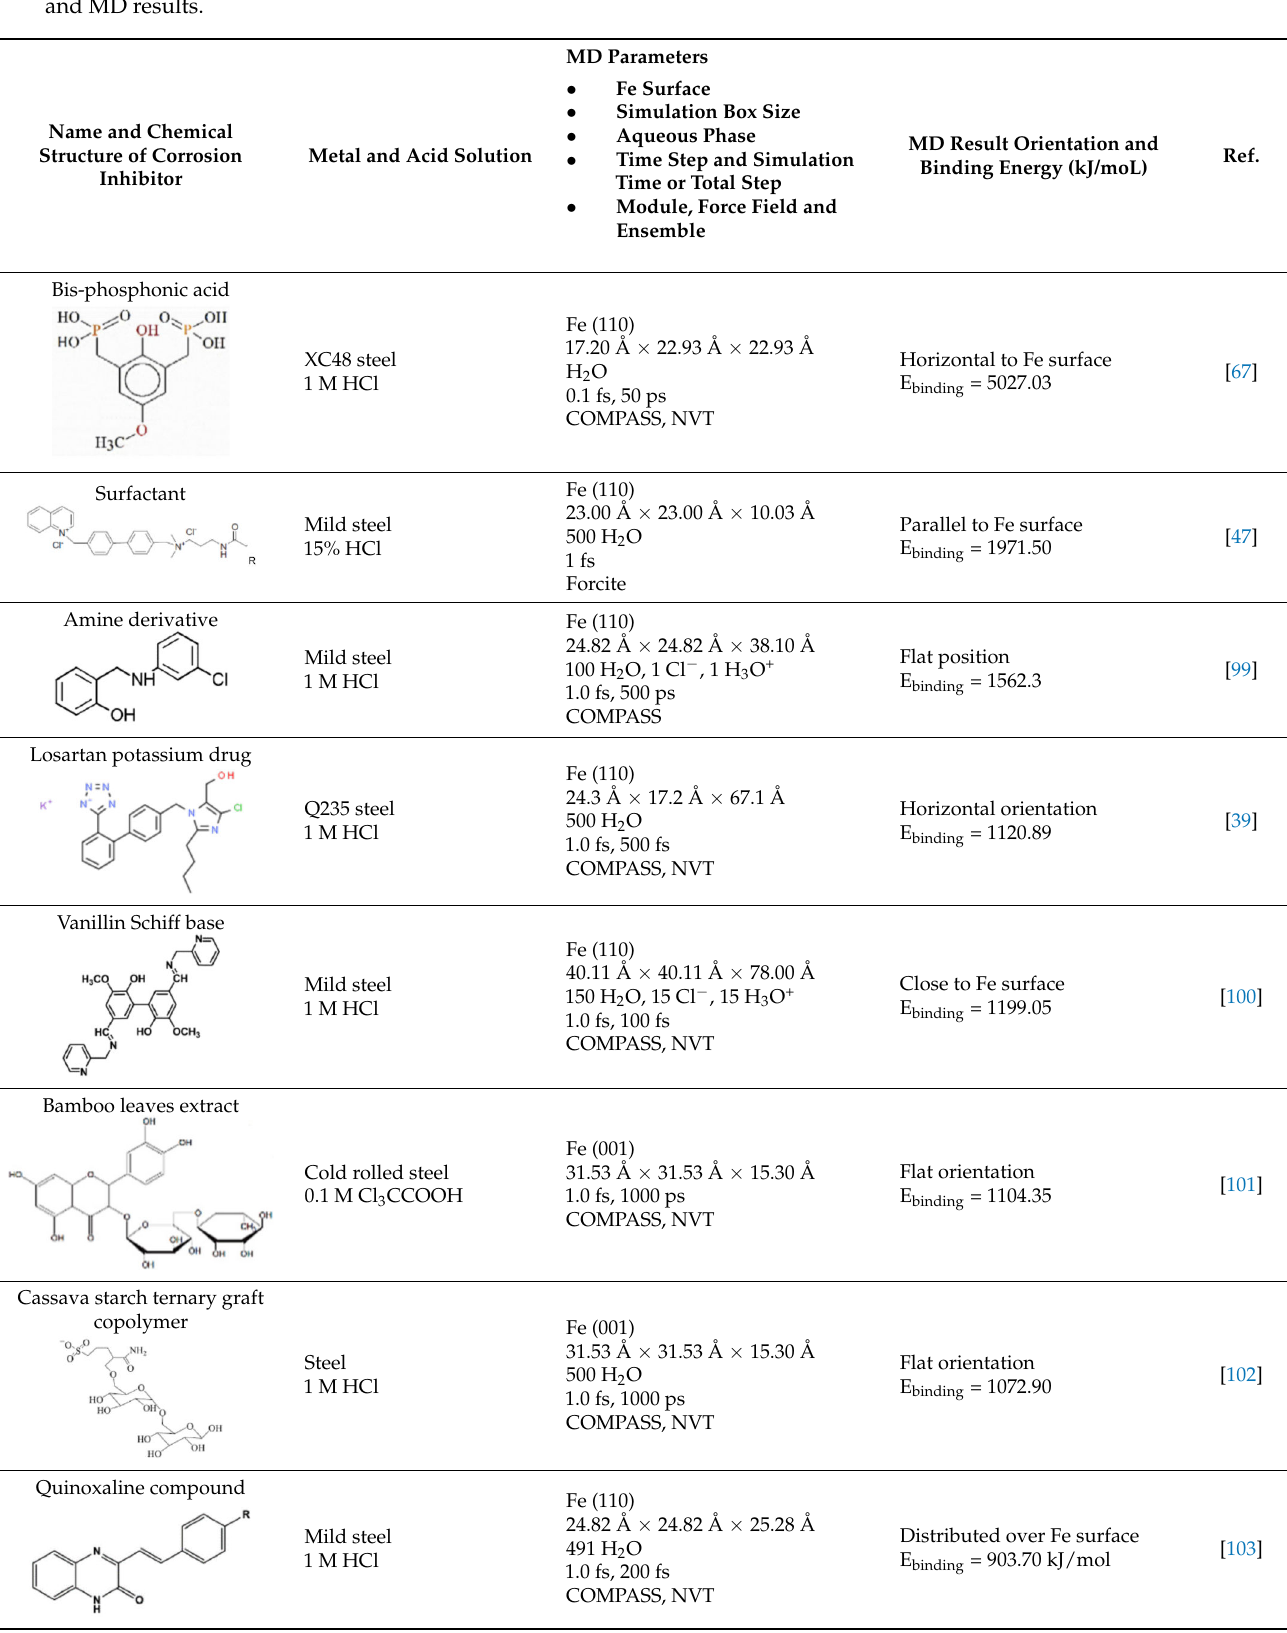
Table 3. Name and chemical structure of corrosion inhibitors for ferrous metals in acid solution, MD simulation parameters and MD